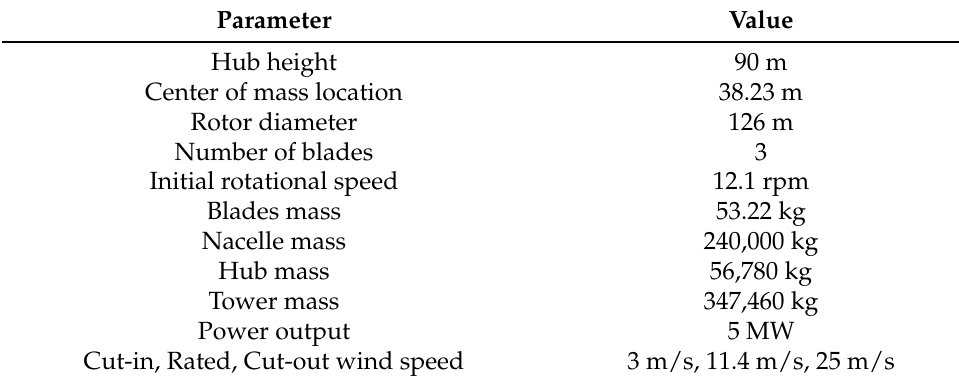
Table 2. Properties of 5-MW floating wind turbine